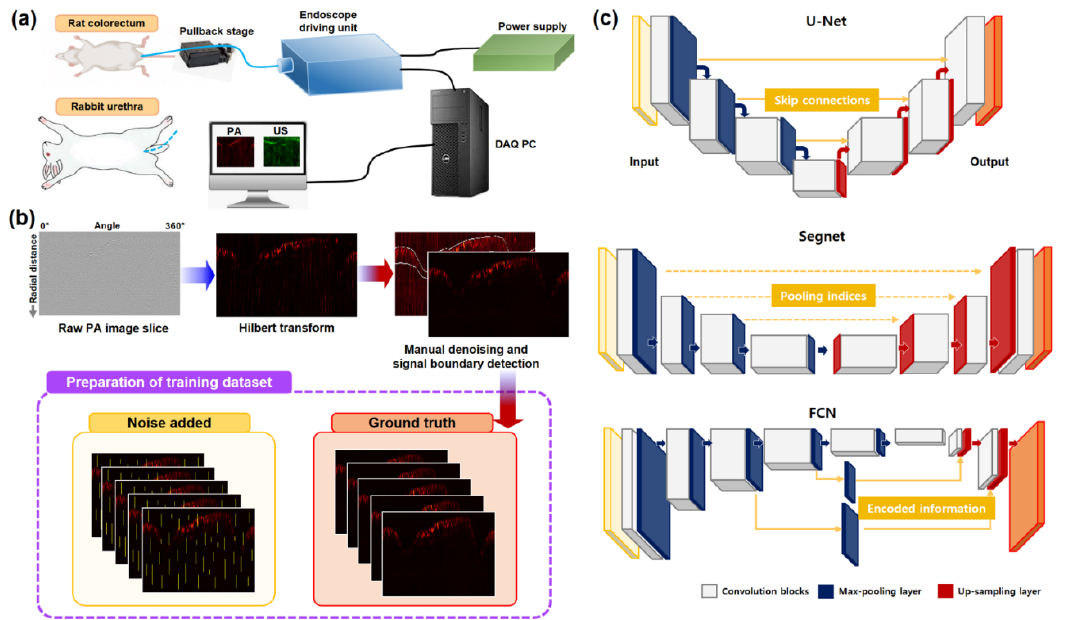
Figure 1. Overview of training data preparation and CNN architectures considered in this study: ( a ) The imaging system we set up, ( b ) data preparation procedure. The EMI noise pattern looks very similar to the blood vessels in the Hilbert ‐ transformed image. ( c ) CNN architectures: U ‐ Net, Segnet, and FCN ‐ 16s. Further details of the networks are provided in Supplementary Figure S1.